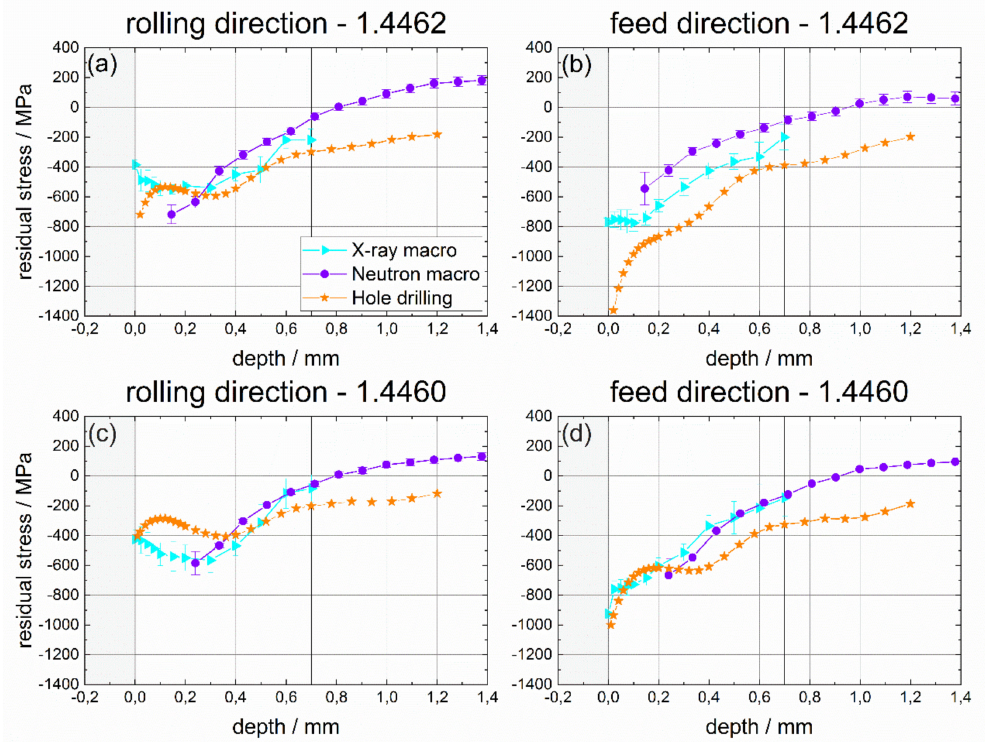
Figure 11. Macro RS determined by means of neutron diffraction, X-ray diffraction and incremental hole drilling in both directions (in the rolling direction (DR) and in the feed direction (FD)) for both materials, i.e., for duplex steel 1.4462 with a phase ratio of 50:50 and for duplex steel 1.4460 with a ferrite to austenite ratio of